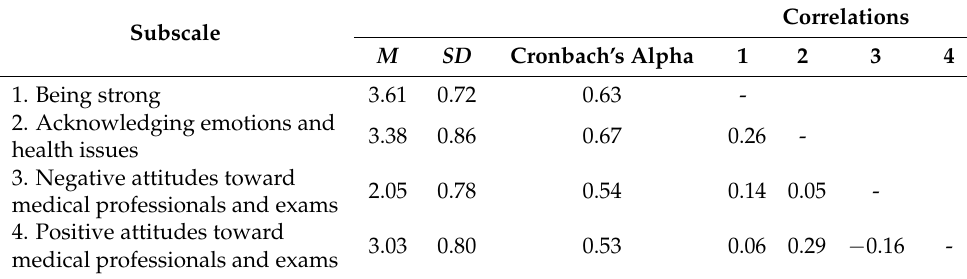
Table 2. Summary of the Masculinity Barriers to Medical Care subscales ( N =